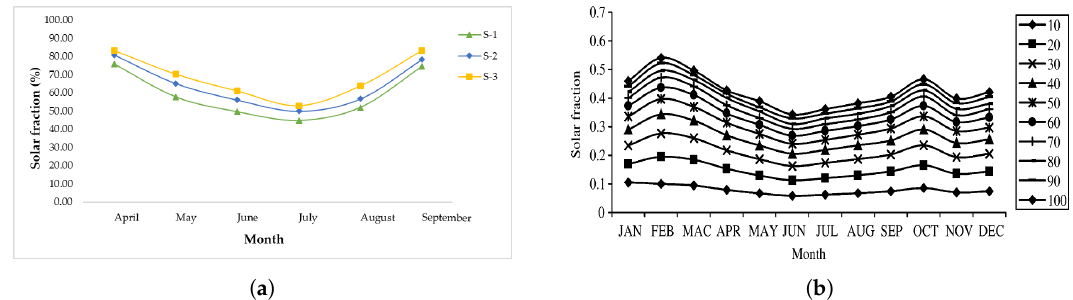
Figure 17. Validation of monthly solar fractions. ( a ) Seasonal solar fraction trend for city of Pakistan. ( b ) Yearly solar fraction trend for city of Malaysia.